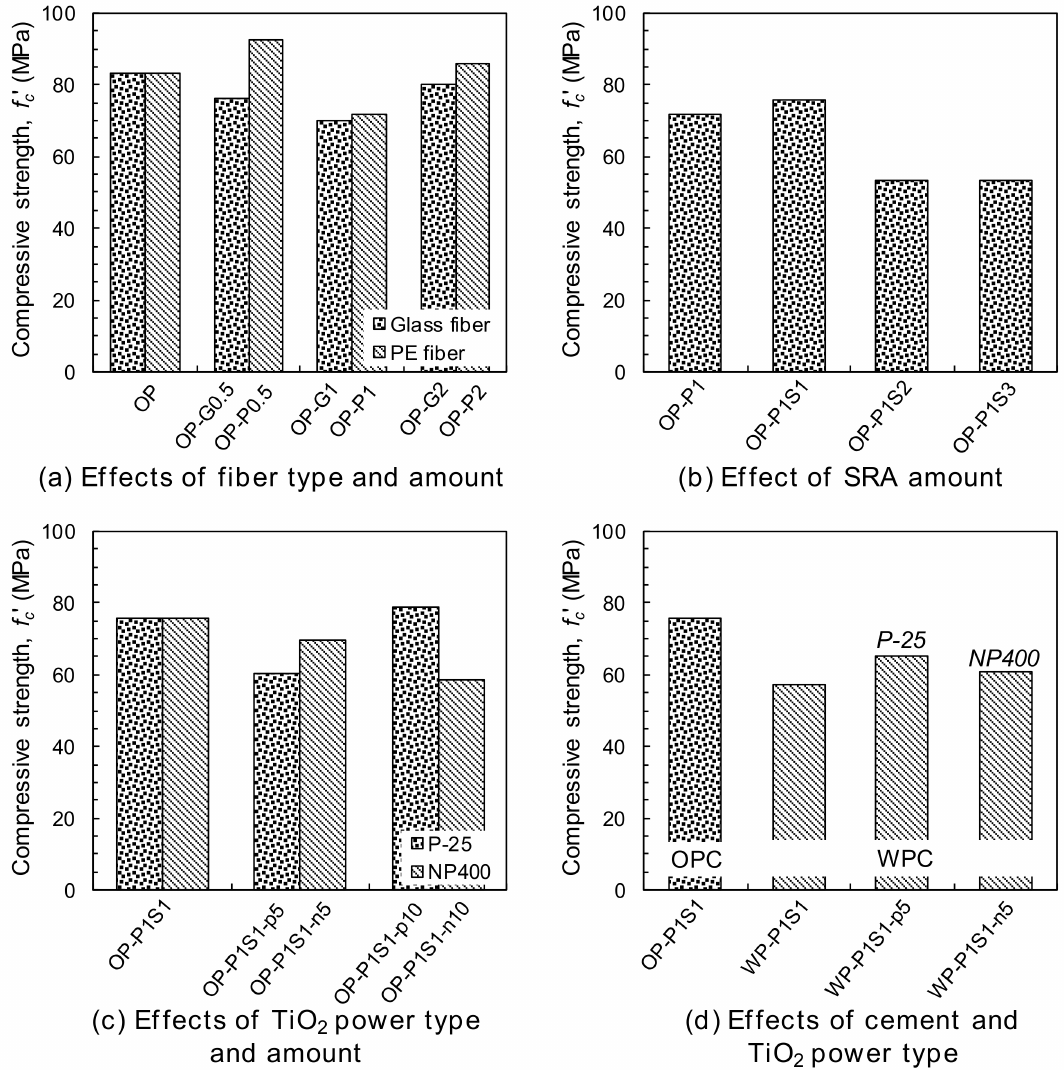
Figure 7. Summary of the compressive strength: ( a ) the e ff ects of fiber type and amount, ( b ) the e ff ect of the SRA amount, ( c ) the e ff ects of the TiO 2 powder type and amount, and ( d ) the e ff ects of the cement and the TiO 2 powder